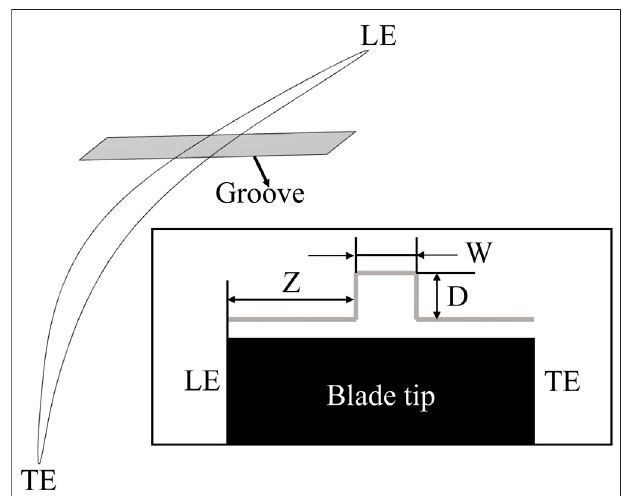
FIGURE 1 | Parameterization of grooved casing treatment.